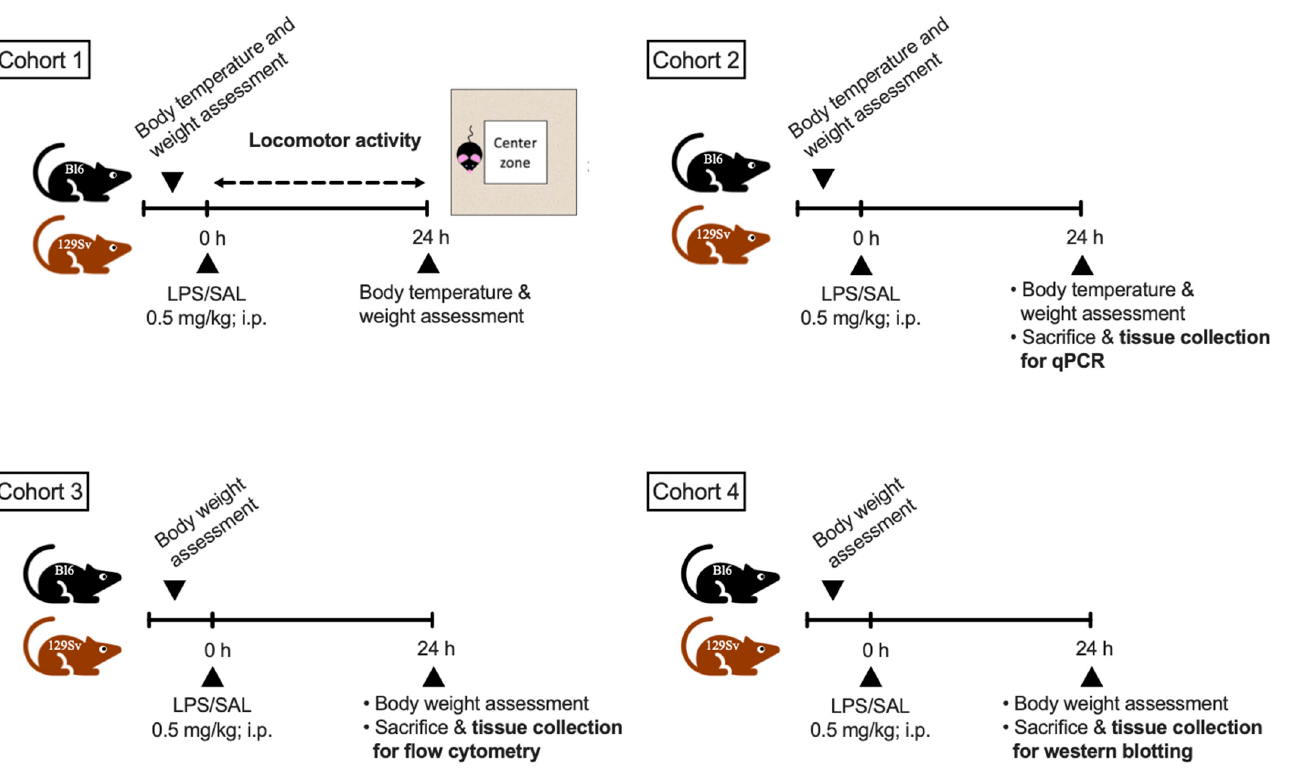
Figure 1. Schematic overview of the experimental